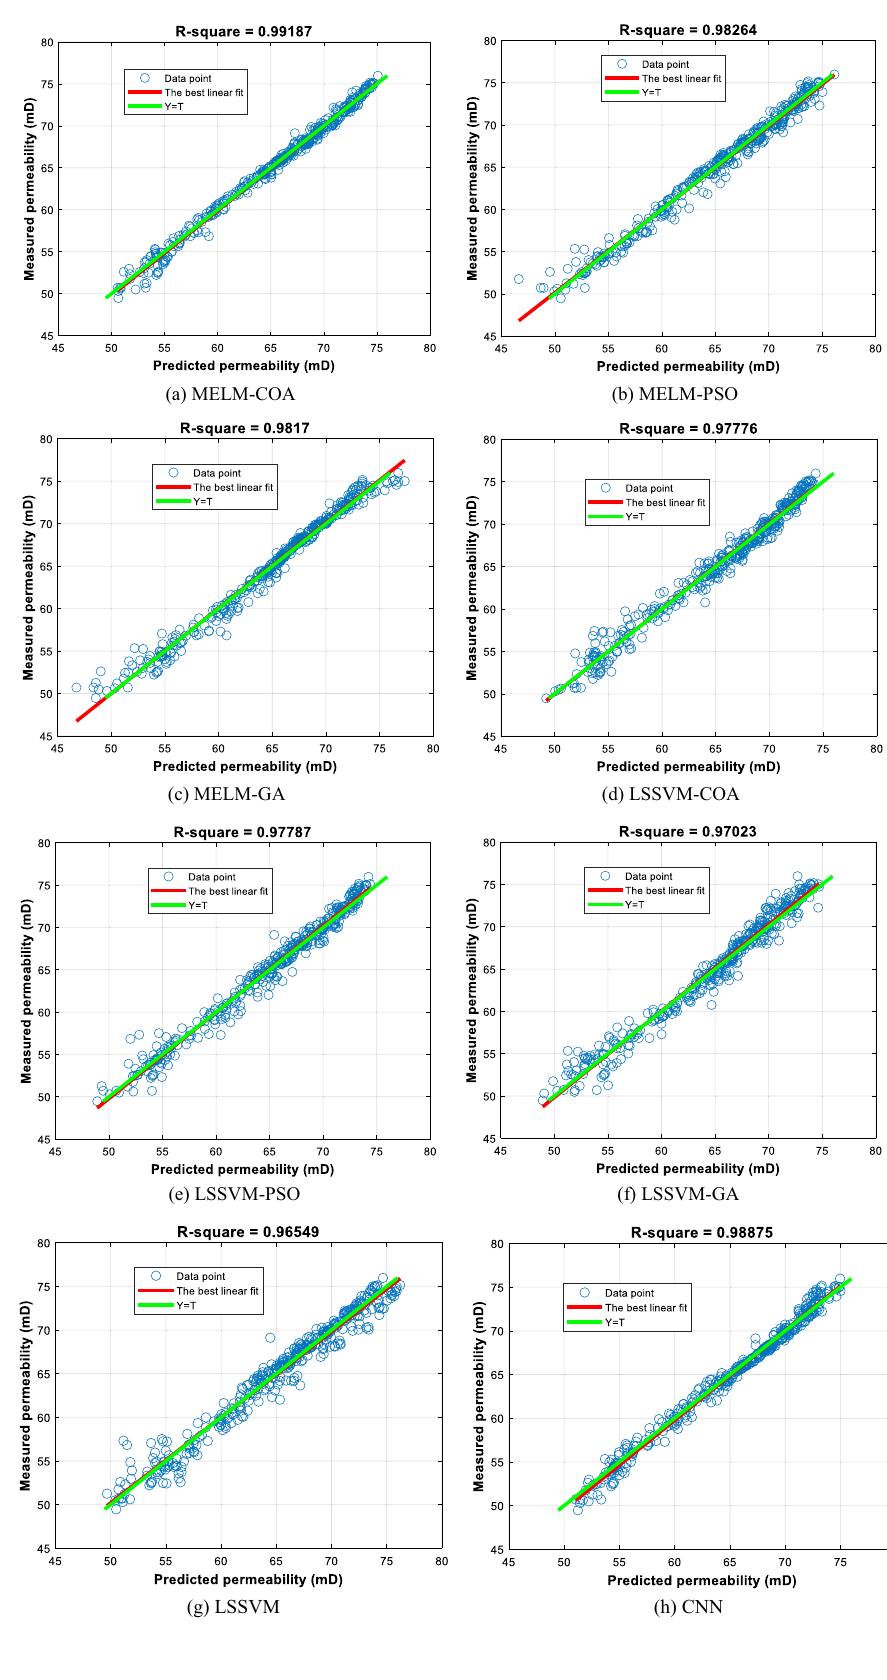
Fig. 11 Cross plots of measured and predicted permeabilities based on the testing data using the hybrid MELM and LSSVM and straightforward LSSVM and CNN techniques. a MELM-COA b MELM-PSO c MELM-GA d LSSVM-COA e LSSVM-PSO f LSSVM-GA